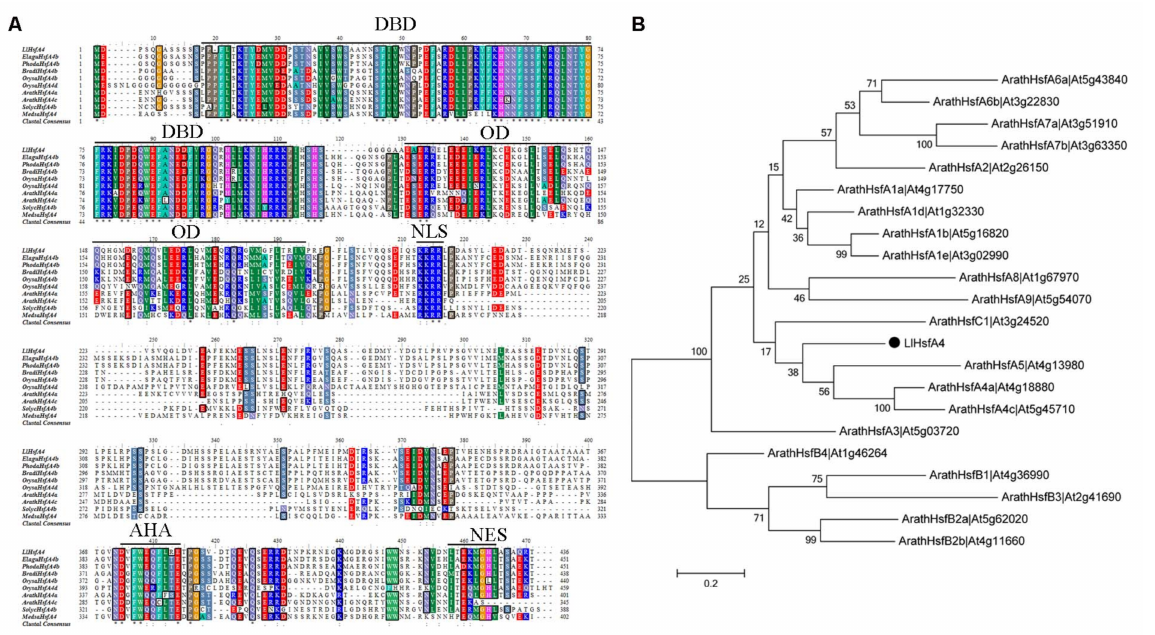
Figure 1. Alignment of amino acid sequence of HsfA4 in different plants. ( A ) Sequence alignment of LlHsfA4 with HsfA4 from Elaeis guineensis , Phoenix dactylifera , Brachypodium distachyon , Oryza sativa , Arabidopsis , Solanumly copersicum and Medicago sativa . The conserved DNA binding domain (DBD), the oligomerization domain (OD), the nuclear localization signal (NLS), activator peptide motifs (AHA) and the nuclear export signal (NES) are indicated by dark colored lines. ( B ) Phylogenetic tree of LlHsfA4 and all HSFs in Arabidopsis . This tree was constructed by ClustalW 2.0 and MEGA 5.0. The dark dot indicates an LlHsfA4